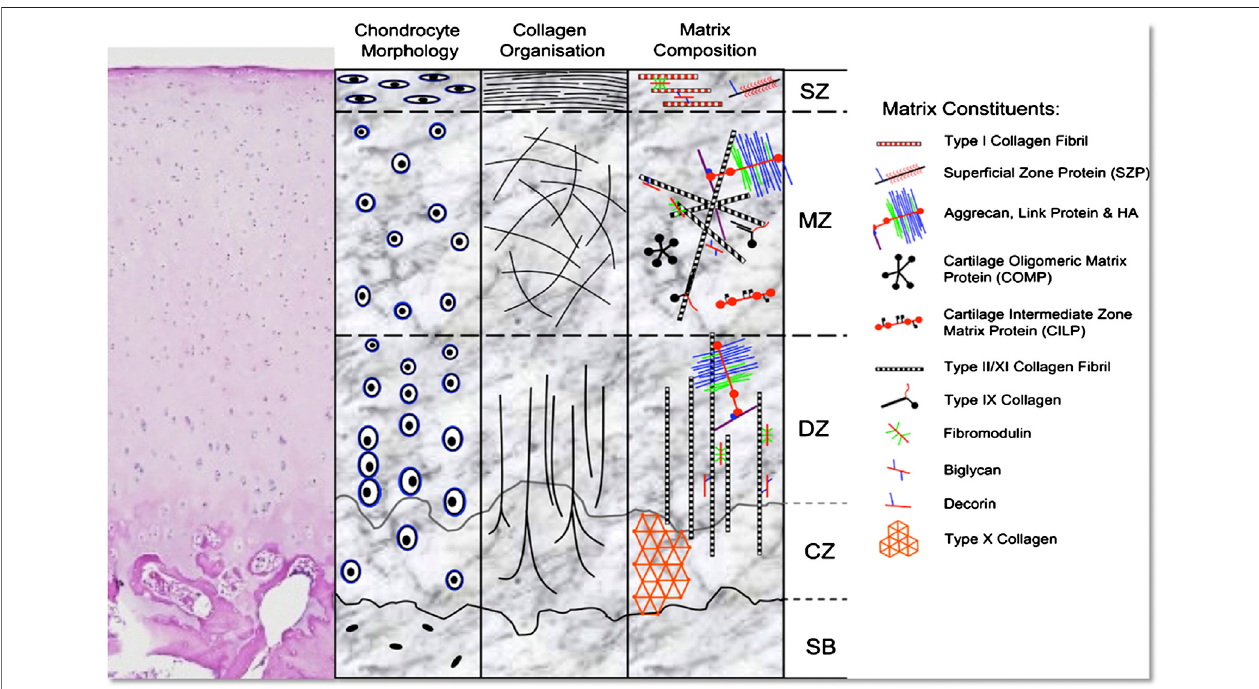
FIGURE 7 | Representation of the morphology and structure of H&E stained hyaline cartilage schematically (SB, subchondral bone; CZ, calci fi ed zone; DZ, deep zone; MZ, middle zone; SZ, super fi cial zone) (Di Bella et al., 2015) (used from an open access journal).